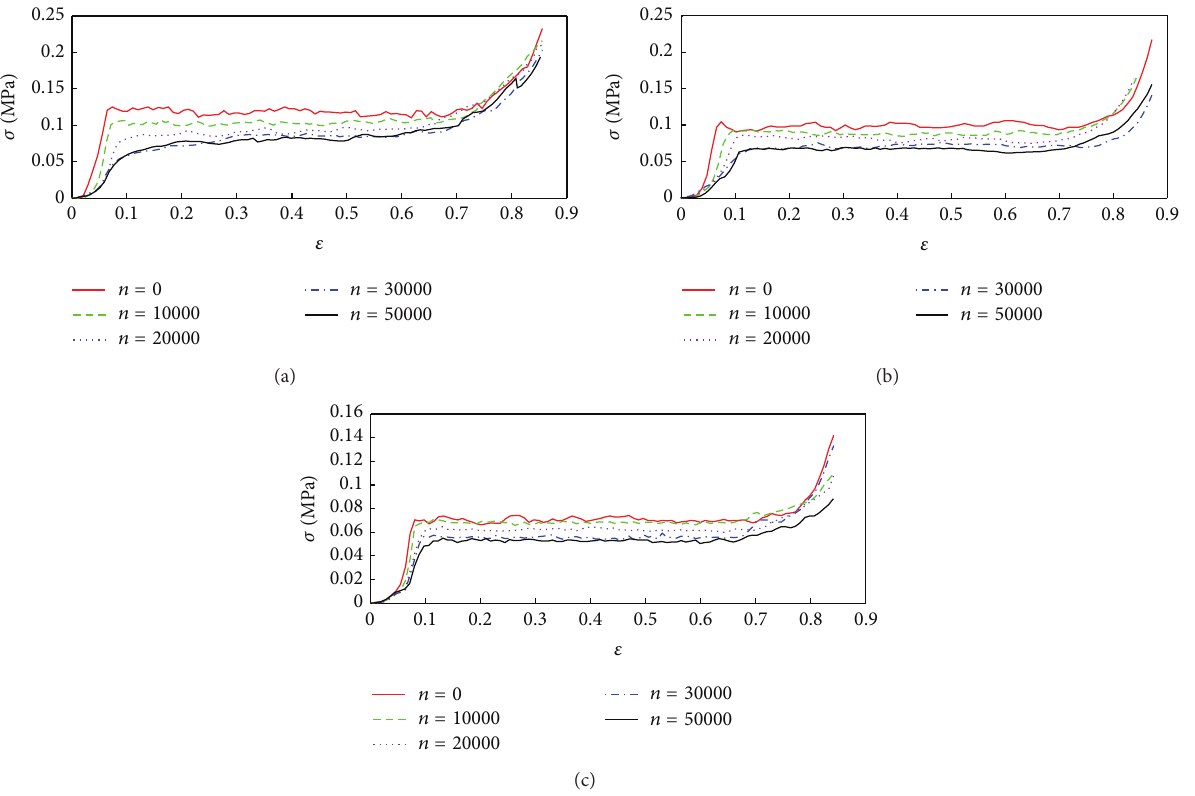
Figure 1: Effect of fatigue stress-strain relationship of precompressed (15% strain ratio) honeycomb paperboard (a) 𝑡/𝑙 = 0.0263 , (b) 𝑡/𝑙 = 0.0238 , and (c) 𝑡/𝑙 = 0.0219 .